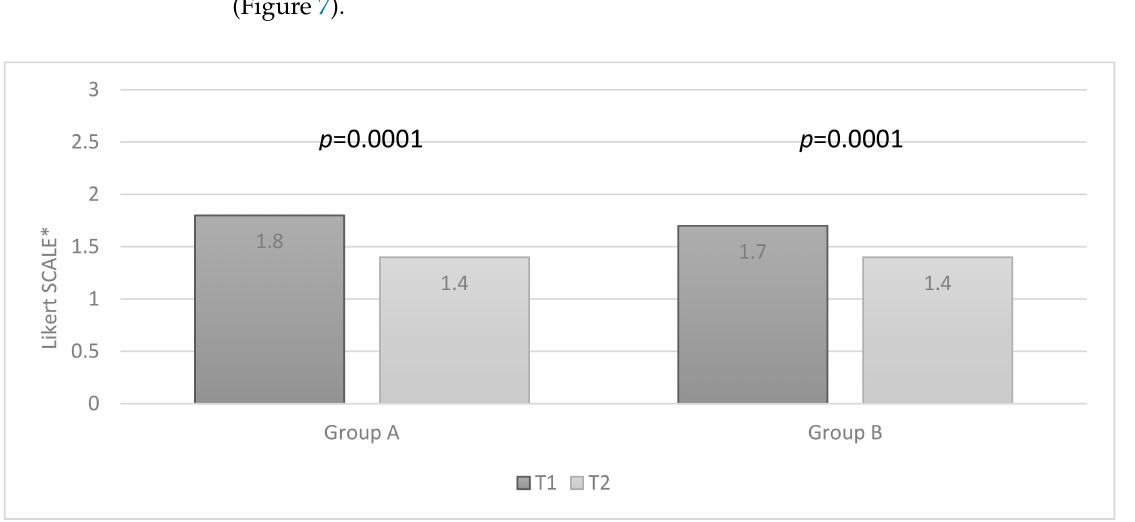
Figure 7. Patients’ satisfaction rate in both groups, comparing T1 and T2 visits (Wilcoxon test). * Likert Scale: four-point scale (0 to